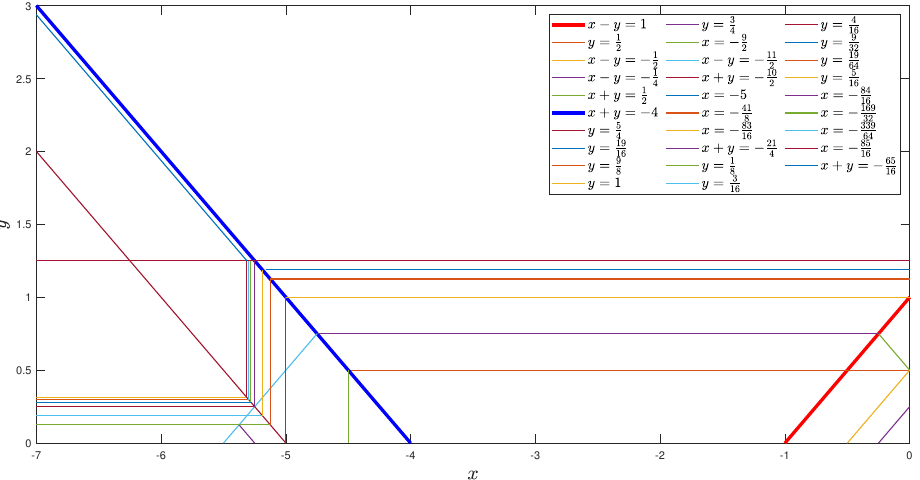
Figure 1. Regions of each case considered when x 0 < 0 and y 0 >